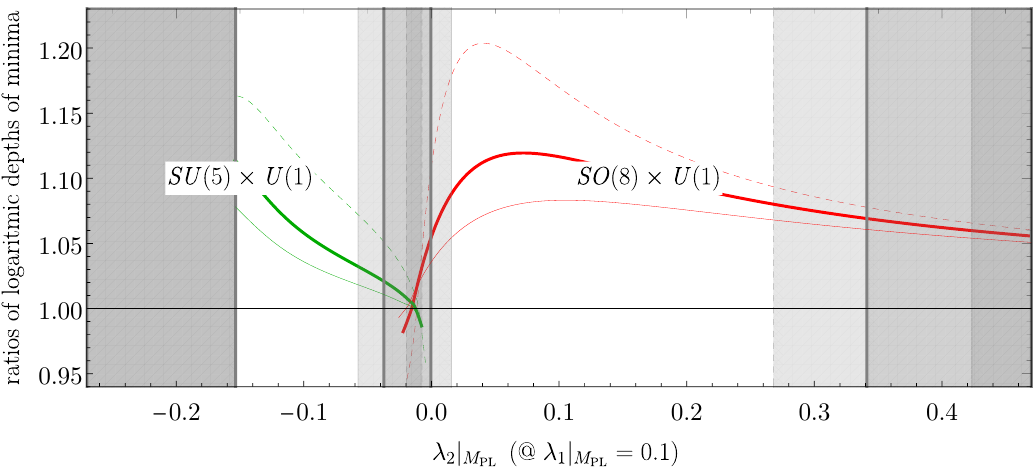
(cid:12) (cid:12) Figure 2 . Ratio of the logarithm of depths, i.e., V i / V Pati-Salam with V i = log (cid:12) V min i (cid:12) , of the minima corresponding to non-Pati-Salam breakings ( SU(5) × U(1) in green and SO(8) × U(1) in red dashed) and the depth of the deepest Pati-Salam minimum V (breaking towards either 3 2 2 1 Pati-Salam C L R B − L or 4 2 1 ). For any Planck-scale initial condition, there is always a non-Pati-Salam minimum C L R which is deeper than the Pati-Salam ones (i.e., there is always one of the ratios which remains larger than one). As an example, we show the λ -dependence at λ = 0 . 1 at g = 0 . 425 , cf. eq. (5.1). As 2 1 M Pl a result, symmetry breaking towards the Pati-Salam subgroups cannot occur. Gray regions indicate regions in which the perturbativity (according to appendix C) is violated, cf. figure 1. All curves and regions are also given for g = 0 . 35 (thin dashed) and g = 0 . 5 M Pl M Pl